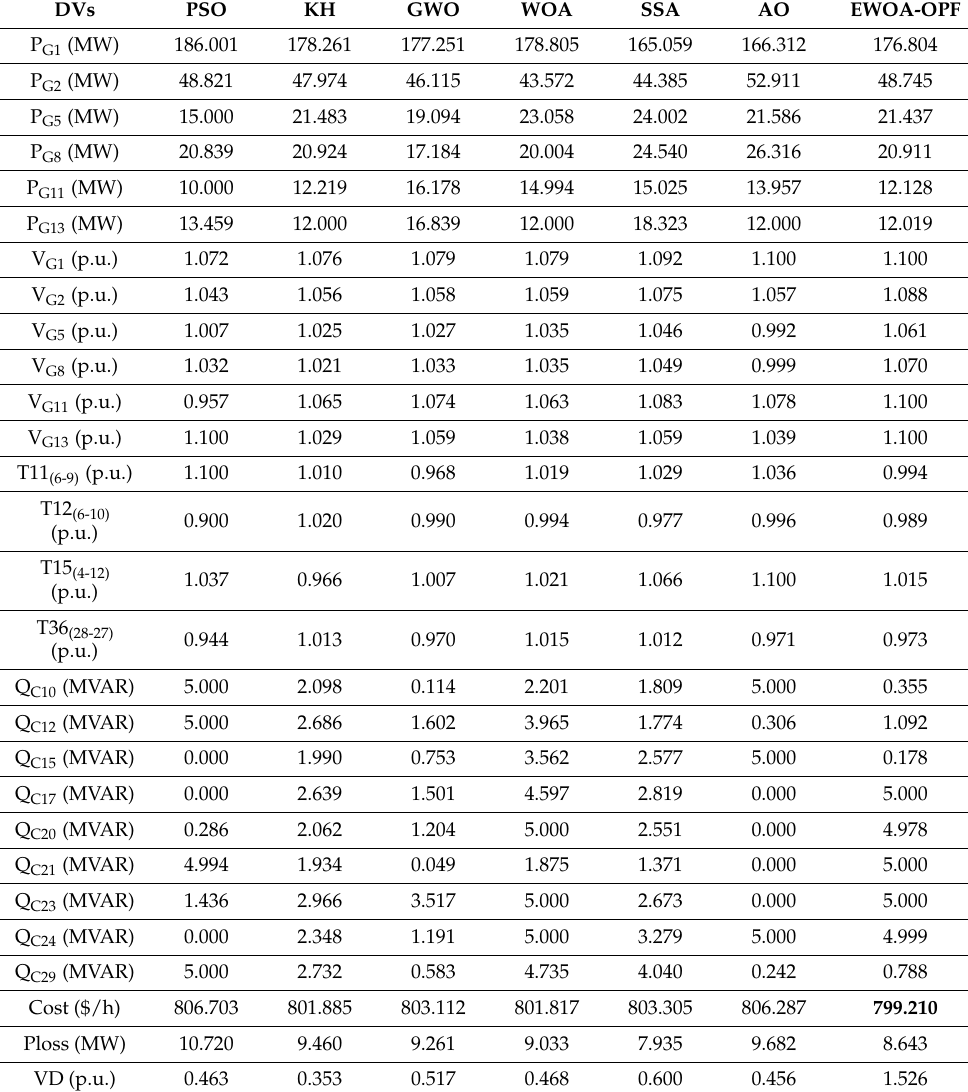
Table 6. Results of OPF for IEEE 30-bus test system on Case 1.